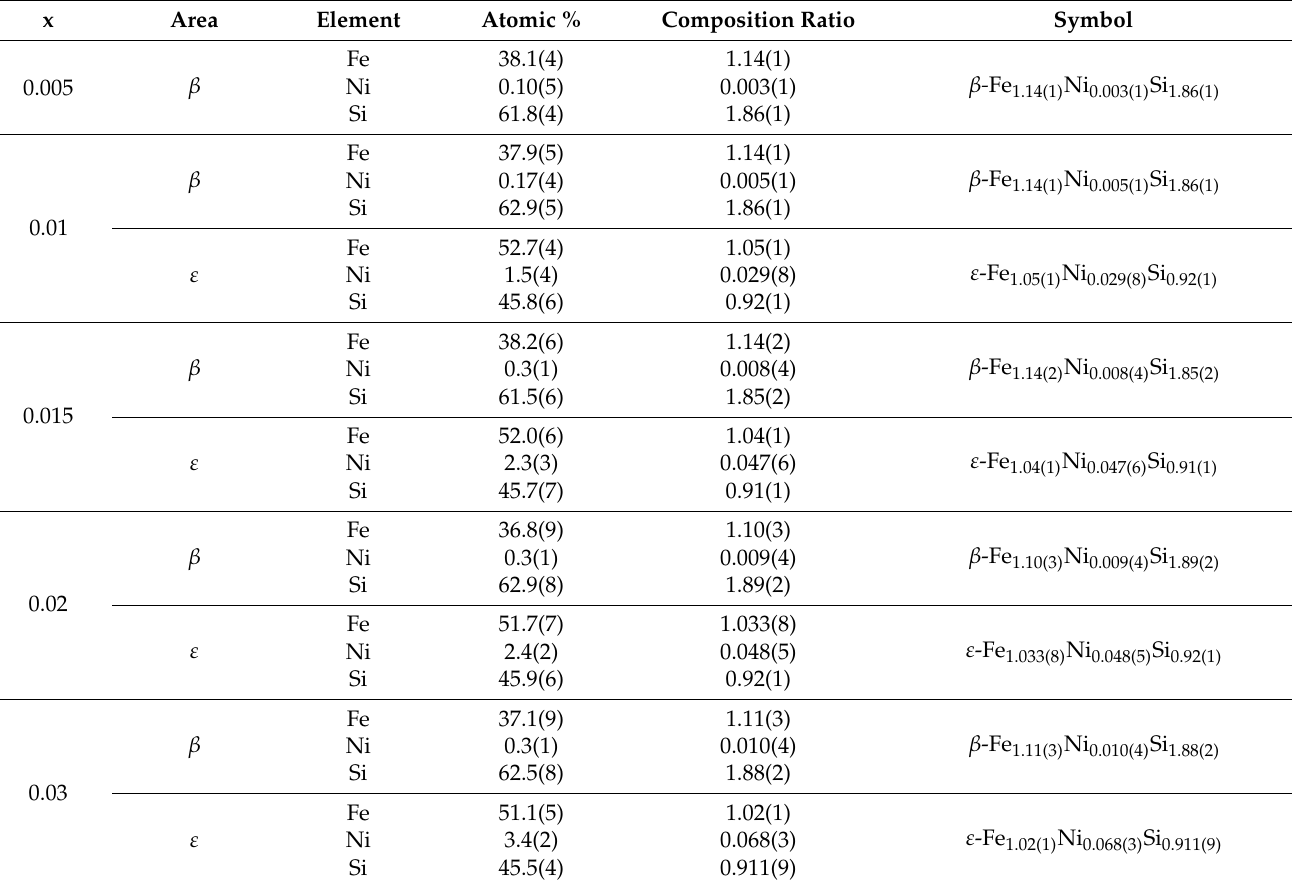
Table 1. Elemental composition of β -Fe 1 − x Ni x Si 2 (0.005 ≤ x ≤ 0.03) quantified by SEM-EDS analysis.